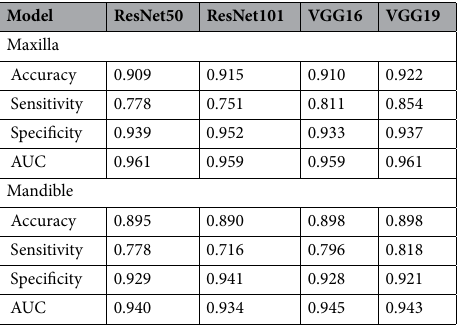
Table 3. Screening performance of tooth extraction diagnosis models.